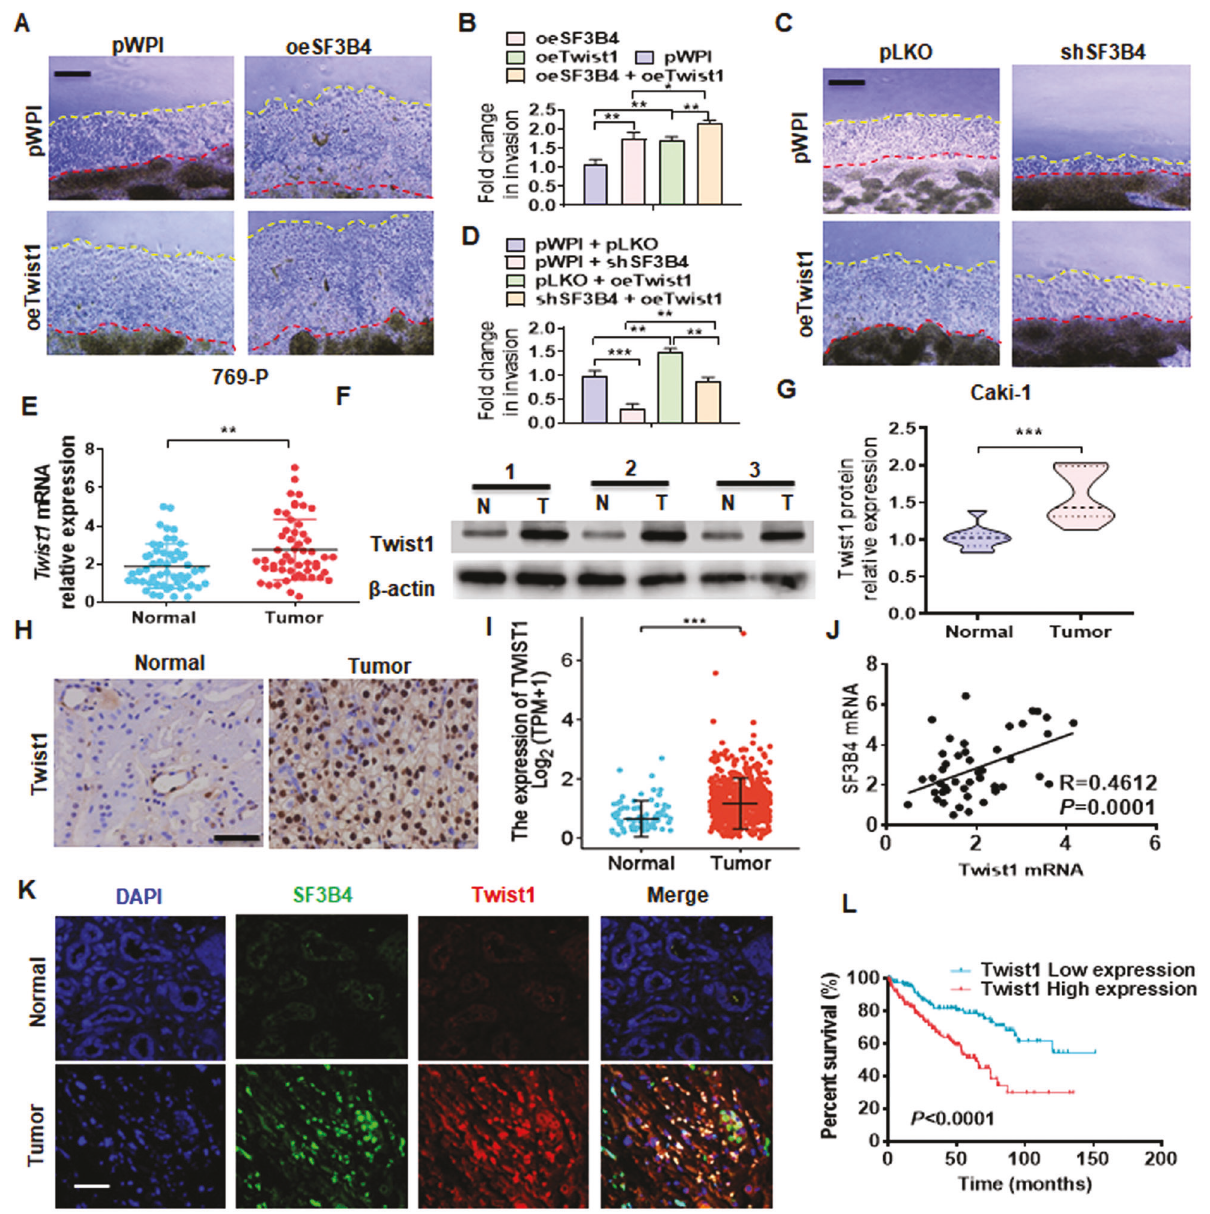
Fig. 4 Upregulation of Twist1 contributes to the progression of ccRCC. A 769-P cells were transfected with oeSF3B4 or oeTwist1, alone or together, and then a 3D Matrigel drop invasion assay detected the invasion of cells. Scale bar = 100 μ m. B Quantitative analysis of A . C Caki-1 cells were transfected with shSF3B4 or oeTwist1, alone or together, and then a 3D Matrigel drop invasion assay detected the invasion of cells. D Quantitative analysis of C . E RT-qPCR detected the Twist1 mRNA expression in normal ( n = 53) and ccRCC ( n = 53) tissues. F , G Twist1 protein level in normal or ccRCC tissues was measured by western blot. H Immunohistochemical staining detected the Twist1 in clinical samples. Scale bar = 50 μ m. I Twist1 mRNA level was analyzed from the TCGA database in normal (N, n = 72) and ccRCC (T, n = 533) tissues. J The correlation between SF3B4 and Twist1 mRNA in ccRCC tissues was analyzed by Pearson correlation analysis of our clinical data (R = 0.4612, P = 0.0001). K Immuno fl uorescence staining detected the expression of SF3B4 and Twist1 in ccRCC and normal renal tissue. Scale bar = 100 μ m. L According to the TCGA database with low and high Twist1 levels, the overall survival of ccRCC patients was analyzed using the Kaplan – Meier method. All data are expressed as the mean ± SEM of three independent experiments. ** P < 0.01, *** P < 0.001 vs. their corresponding Twist1 gene, and detected Twist1 mRNA expression in Caki-1 (Supplementary Table 2) by combining the number of co- cells. As shown in Fig. 5B, depletion of KLF16 or SP1 signi fi cantly expression genes with SF3B4 in renal cancer (Supplementary reduced Twist1 expression, while siRNA-mediated knockdown of Table 3) and transcription factors from Uniprot database TAF6 elevated Twist1 mRNA level. Subsequently, we knocked (Supplementary table 4). We found that transcription factors, down or overexpressed SF3B4 and detected the KLF16 expres- KLF16, may be involved in the regulation of SF3B4 to Twist1 sion. The results showed that the depletion of SF3B4 in Caki-1 (Fig. 5A). Therefore, we knocked down some transcription factors, cells reduced, while its overexpression in 769-P cells enhanced which were speculated to be related to transcription activation of